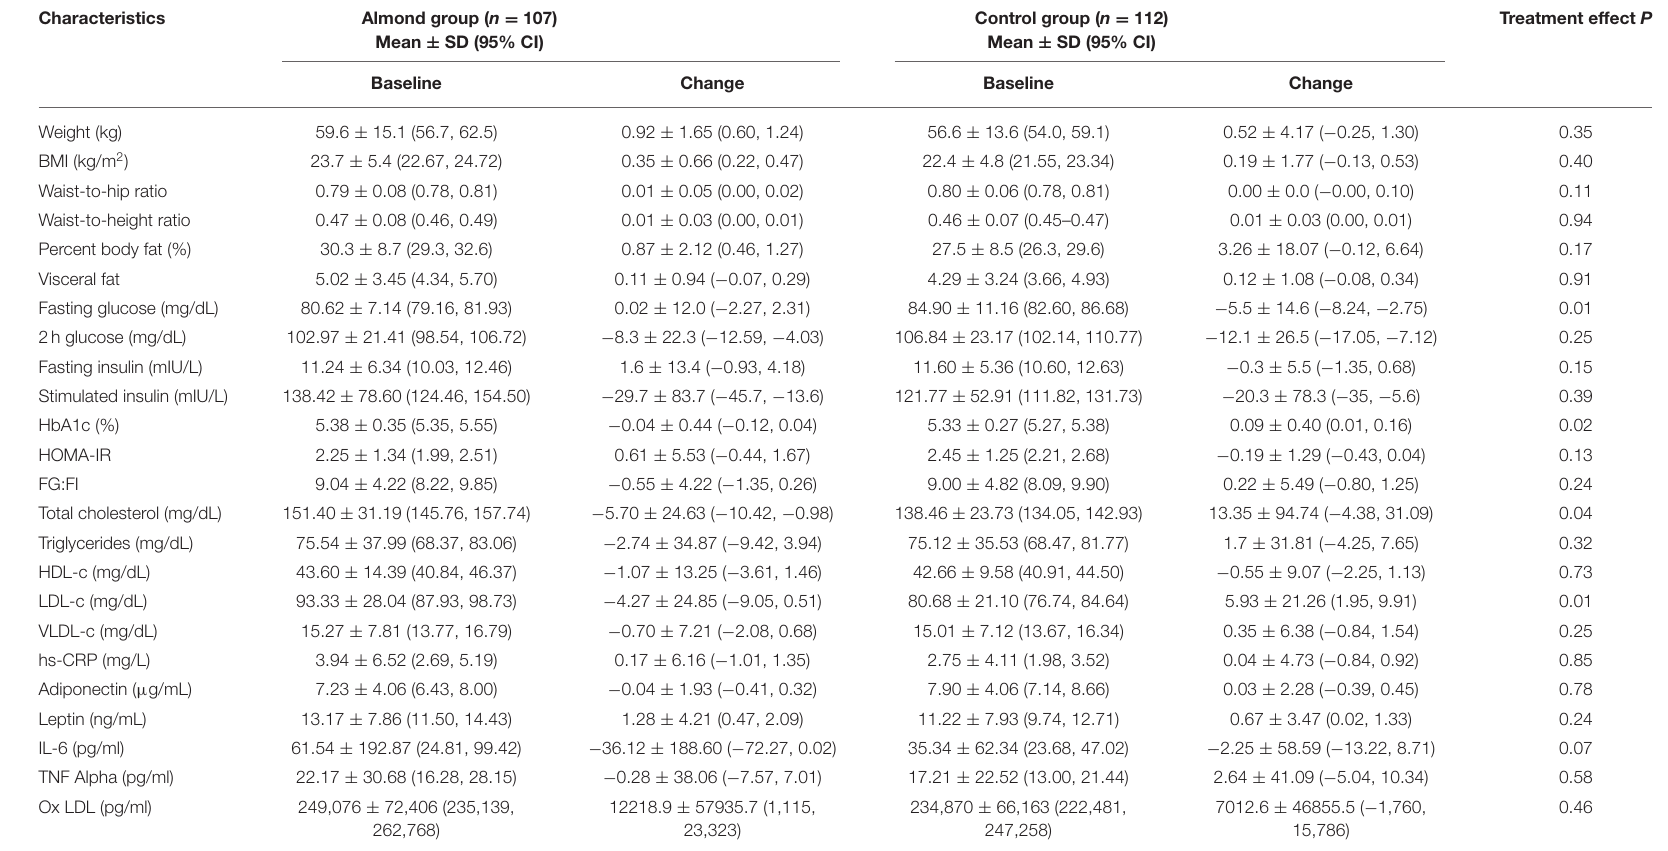
TABLE 1 | Mean baseline and change in anthropometric indices, glucose, insulin, lipid profile, inflammatory markers, and oxidized LDL in control and almonds groups.